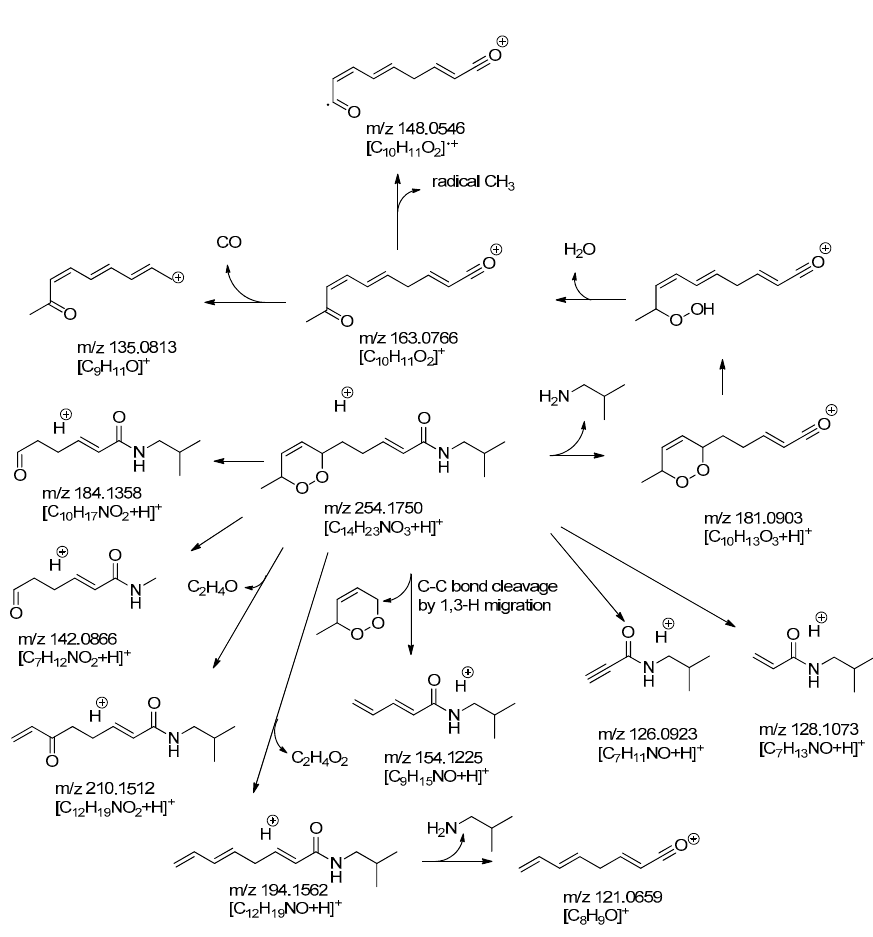
Figure 4. Proposed fragmentation mechanism of the endoperoxide alkamide ( m / z 254). Table 3. Calculated and experimental chemical shift values and differences for protons at the endoperoxide ring of compound 3 . Upfield shifts comparing the first and second columns of calculated and experimental data, respectively, are colored in blue, downfield shifts in red. Calc.